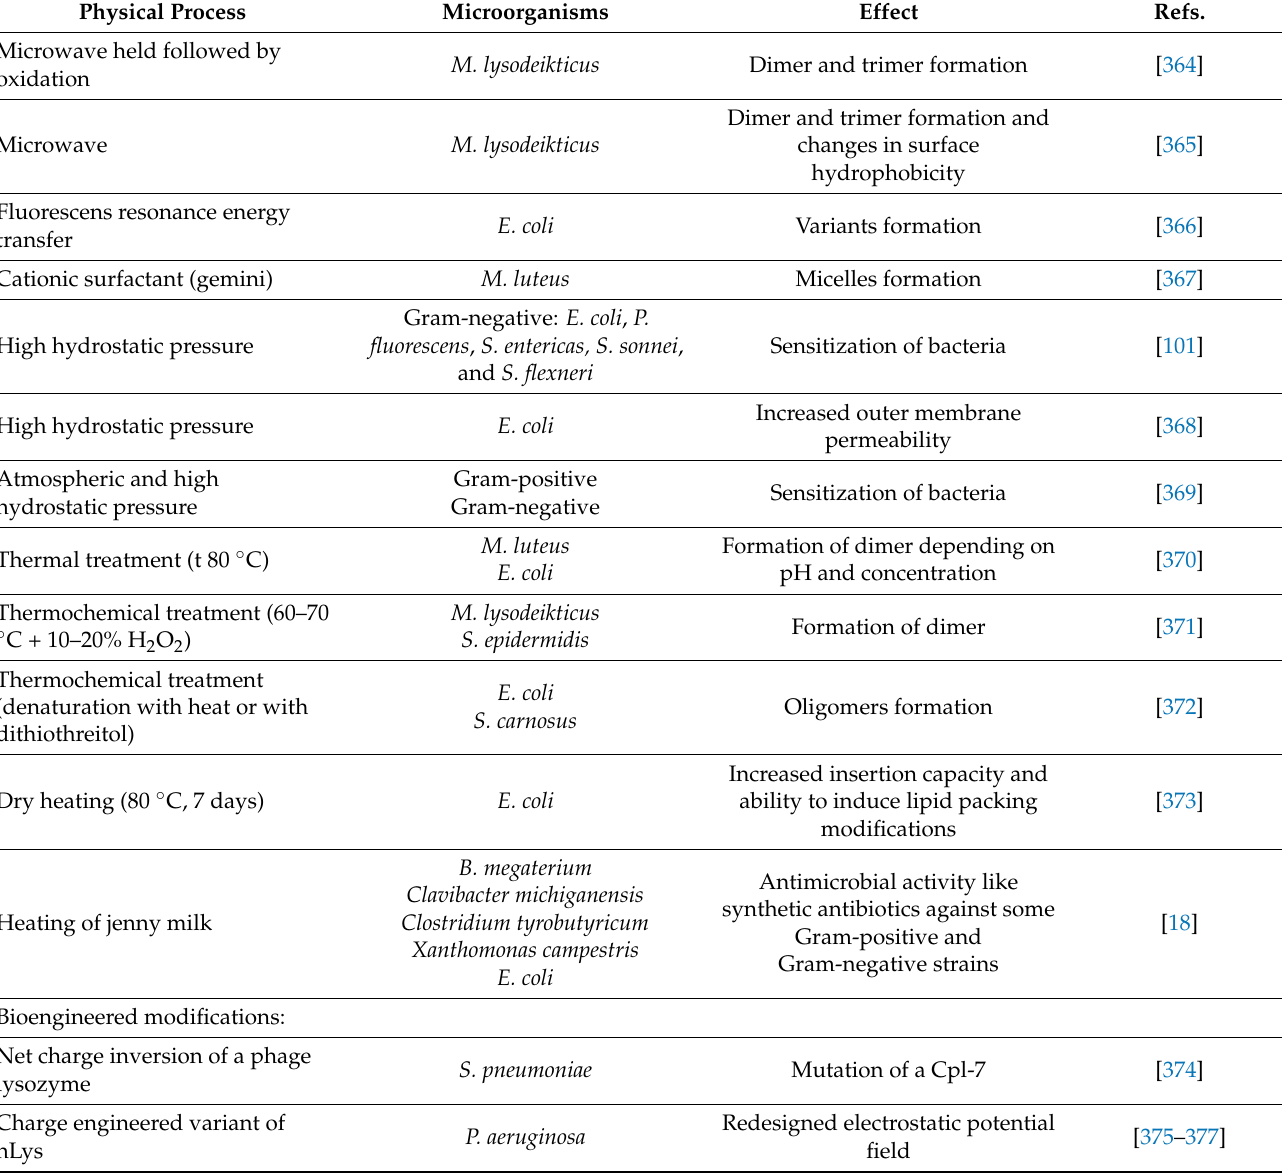
Table 8. Physical modifications of